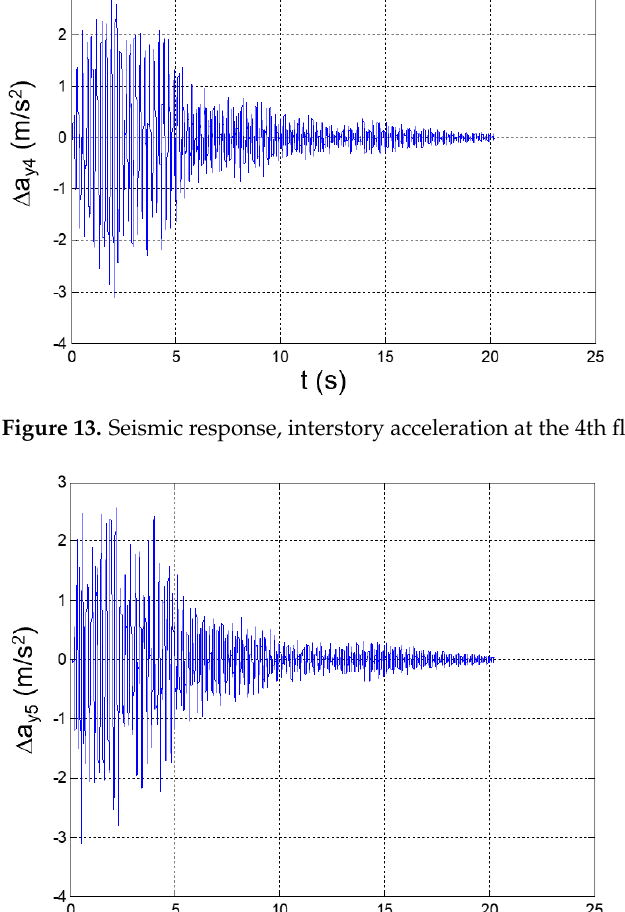
Figure 14. Seismic response, interstory acceleration at the 5th floor ( Δ 𝑎 y5 = 𝑎 y5 − 𝑎 y4 ).